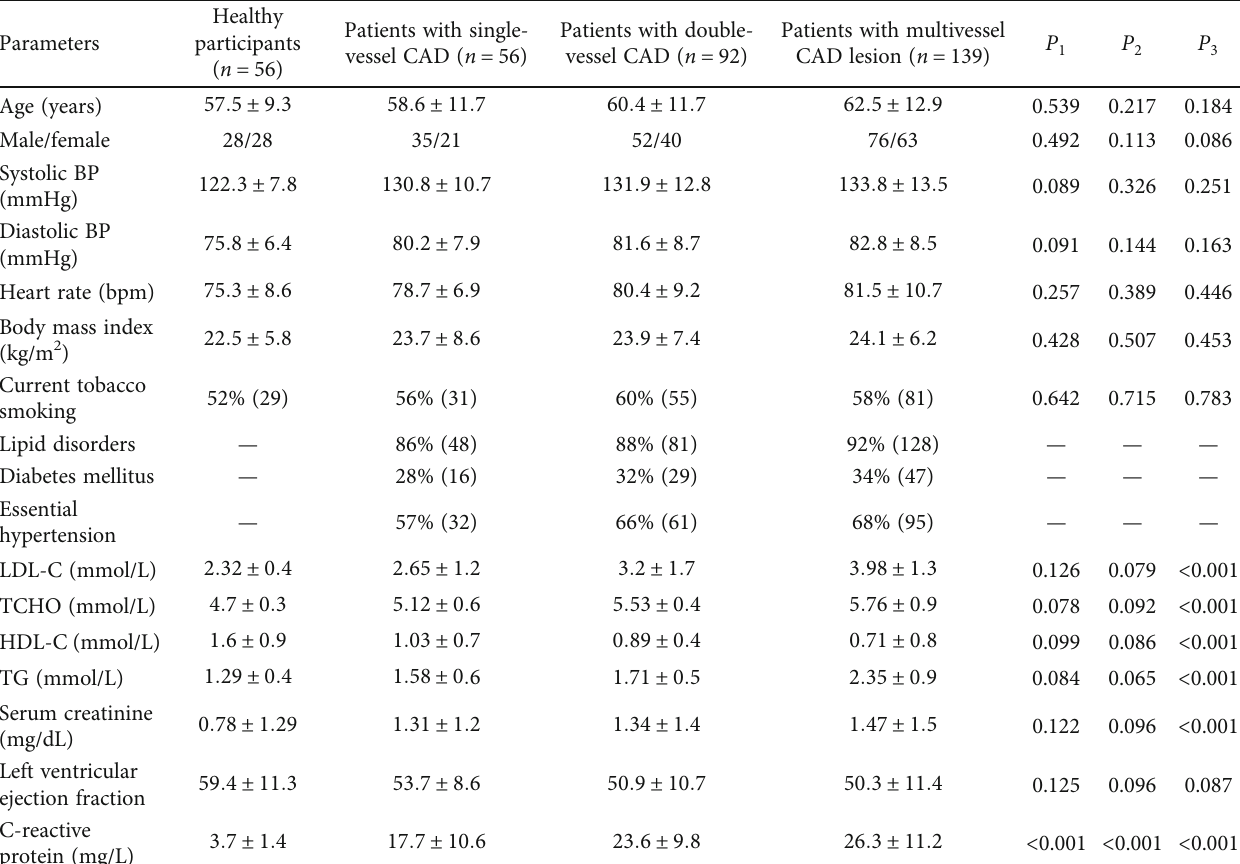
Table 2: Baseline features of the study